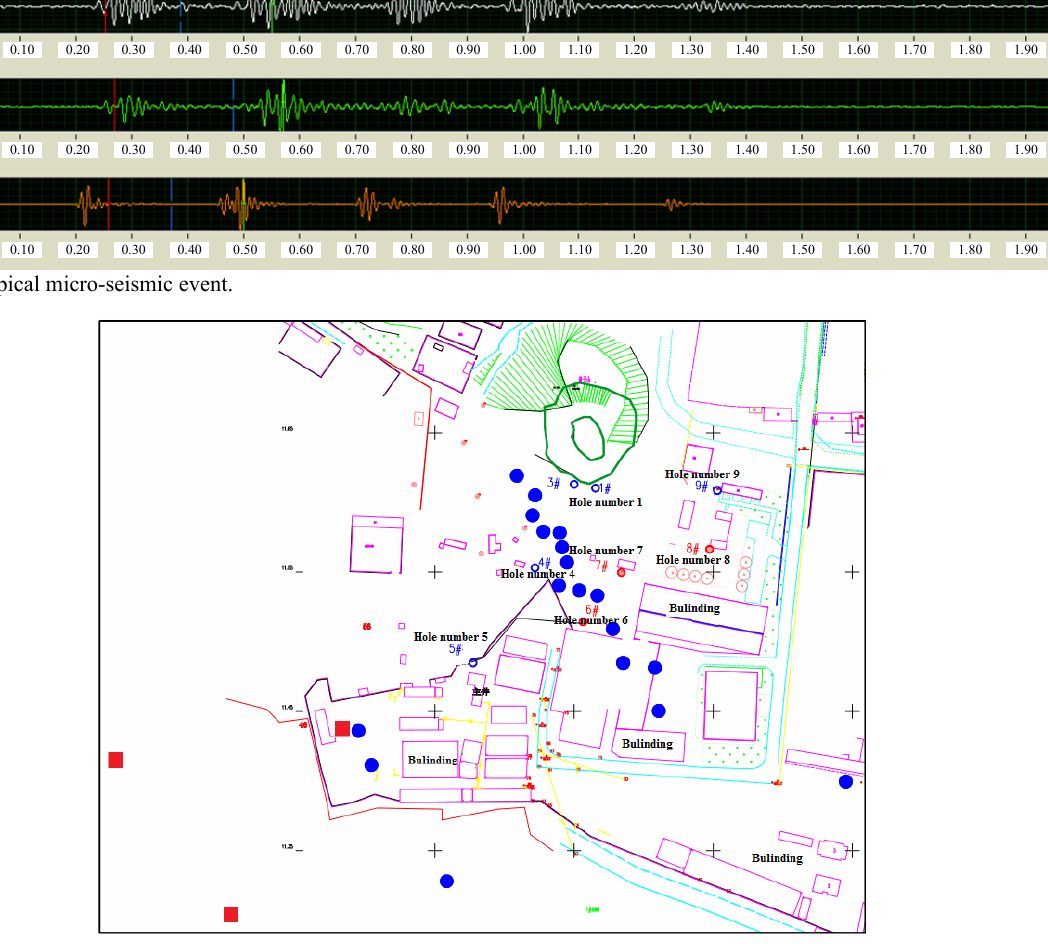
Fig. 11 Plane distribution of micro-seismic